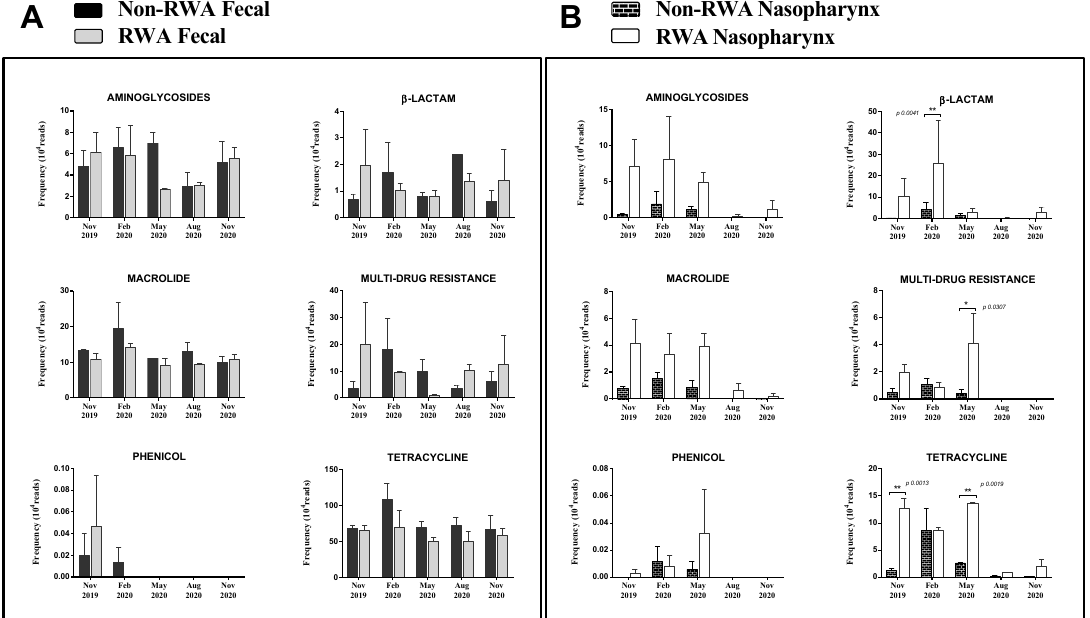
Figure 4. Resistomes from sow feces ( A ) and sow nasopharynx ( B ) in RWA + (plus sign) and non- RWA − (minus sign) barns. The frequency of antibiotic resistance genes (ARG) clustered in six classes: aminoglycoside, β -lactam, macrolide, MDR, phenicol, and tetracycline. Two data sets from each type of barn (non-RWA and RWA) were included as biological replicates for statistical analysis. ANOVA 2-way analysis with repeated measures comparing RWA vs. non-RWA with Bonferroni’s correction; * p < 0.05, ** p < 0.01. Figure 5 shows the frequencies of the ten most abundant ARGs in sow feces and nasal swab samples from RWA and non-RWA barns. Through comparative gene frequency (heat map) analysis of ARG clusters, tetracycline resistance genes tetW and tetQ were the most frequently found in fecal samples, and the β -lactam resistance gene blaROB1 was the most frequently found in nasal swab samples, followed by Aminoglycoside ( ant9 la ) and then by MDR ( lsaE ) (Figure 5A). Furthermore, PCoA ordination of ARGs significantly clustered the effect of RWA on the resistome from sow nasal swab samples ( p = 0.016), but not from sow feces ( p = 0.072) (Figure 5B).